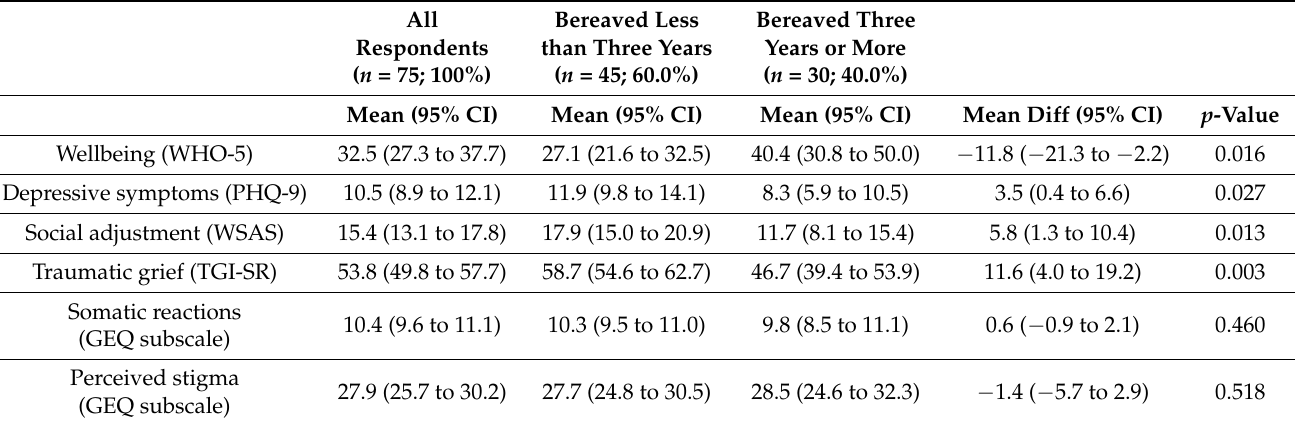
Table 2. Baseline outcome measures and differences according to time since bereavement ( n =